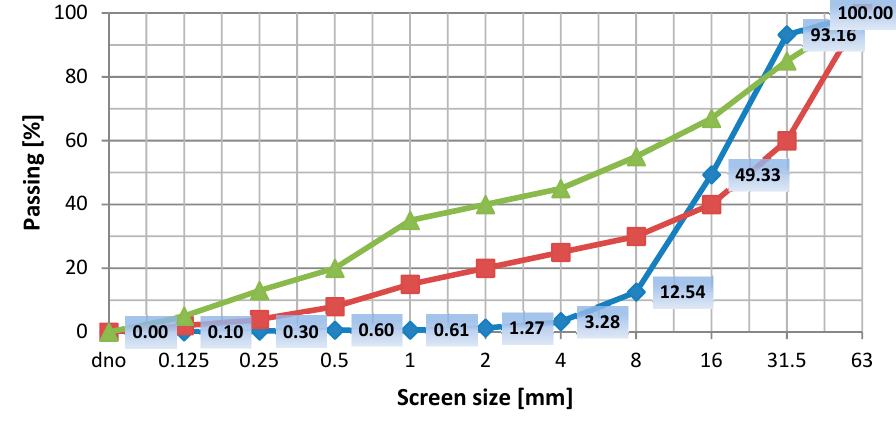
Figure 2. Graphical presentation of the sieve analysis. Grading curves. Recyclate curve compared to the standard good grading field.